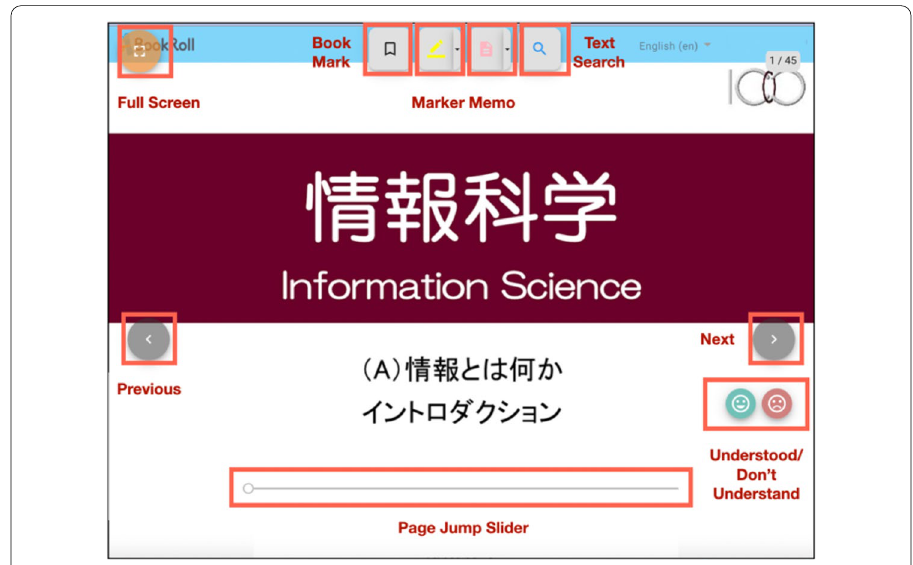
Fig. 2 The screenshot of BookRoll